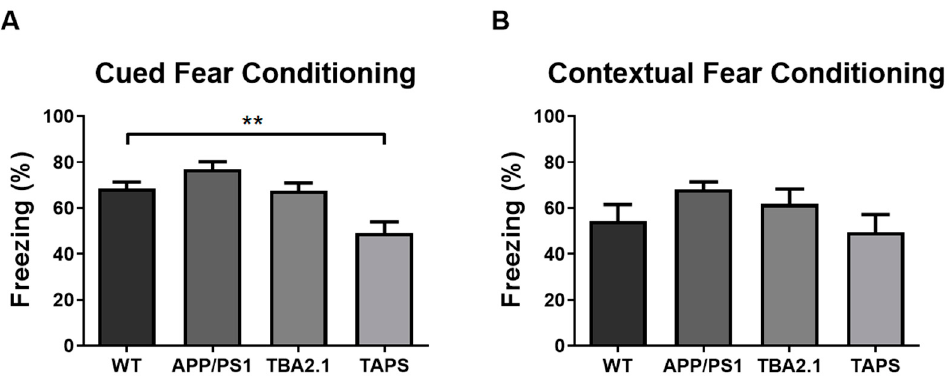
Figure 9. Impaired fear conditioning learning in TAPS mice. The percentage of freezing behavior was measured in the contextual and cued fear conditioning paradigm with 18 months of age. In the cued fear conditioning ( A ), the TAPS mice ( n = 4) froze less compared to the wild-type (WT; n = 8) mice indicating a deficit in fear conditioning learning (** p = 0.0042). Both, APP/PS1 ( n = 4) and TBA2.1 ( n = 8), showed similar freezing behavior compared to WT mice, indicating intact fear conditioning learning. In the contextual fear conditioning ( B ), all genotypes showed similar freezing behavior. For statistical analysis, one-way ANOVA with Dunnettt´s post-hoc was used to compare the genotypes. Data is given as mean + SEM.